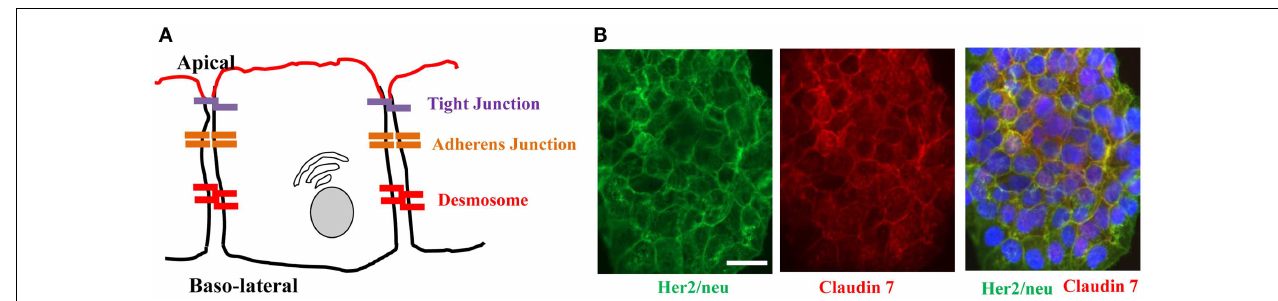
spot-like adhesions randomly arranged on lateral sides of plasma membranes. A key desmosomal junction protein is desmoglein 2 (DSG2). (B) Target receptors for cancer therapy are often trapped in epithelial junctions. Shown are breast cancer cells stained for Her2/neu (the target receptor for trastuzumab/Herceptin™) and the junction protein claudin 7.The merged image shows colocalization of both proteins in junctions between cells.